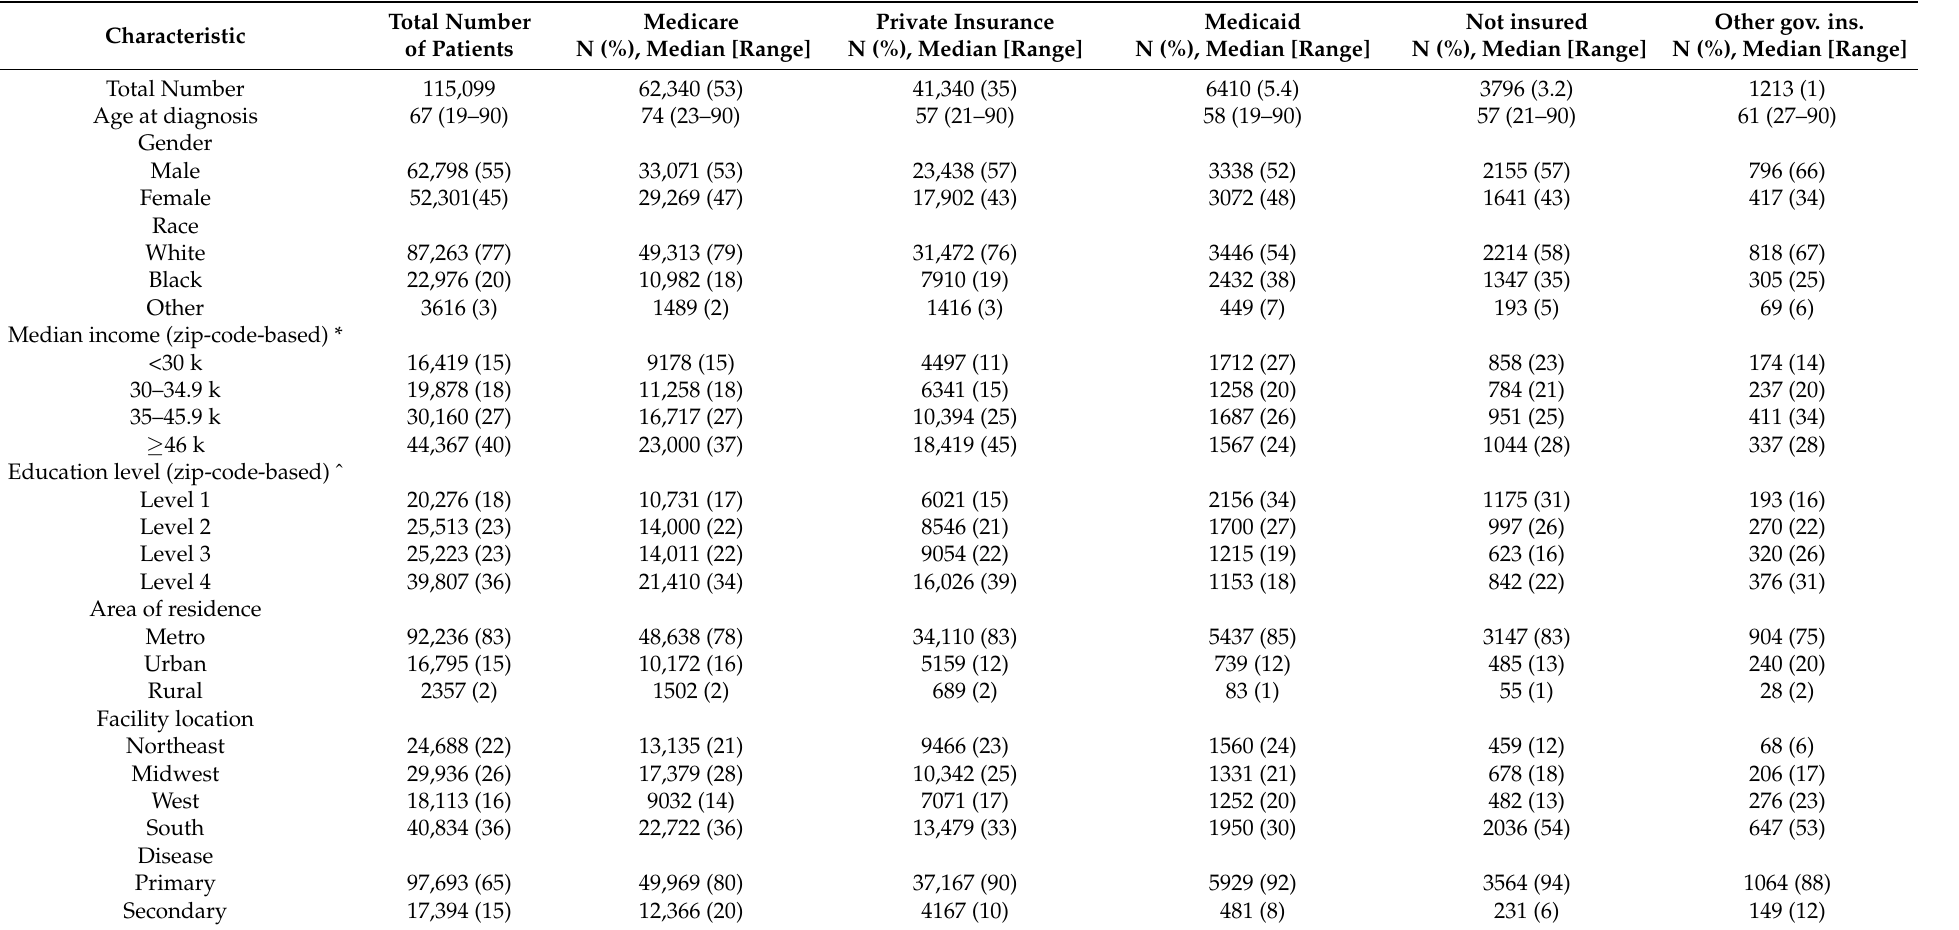
Table 1. Patient